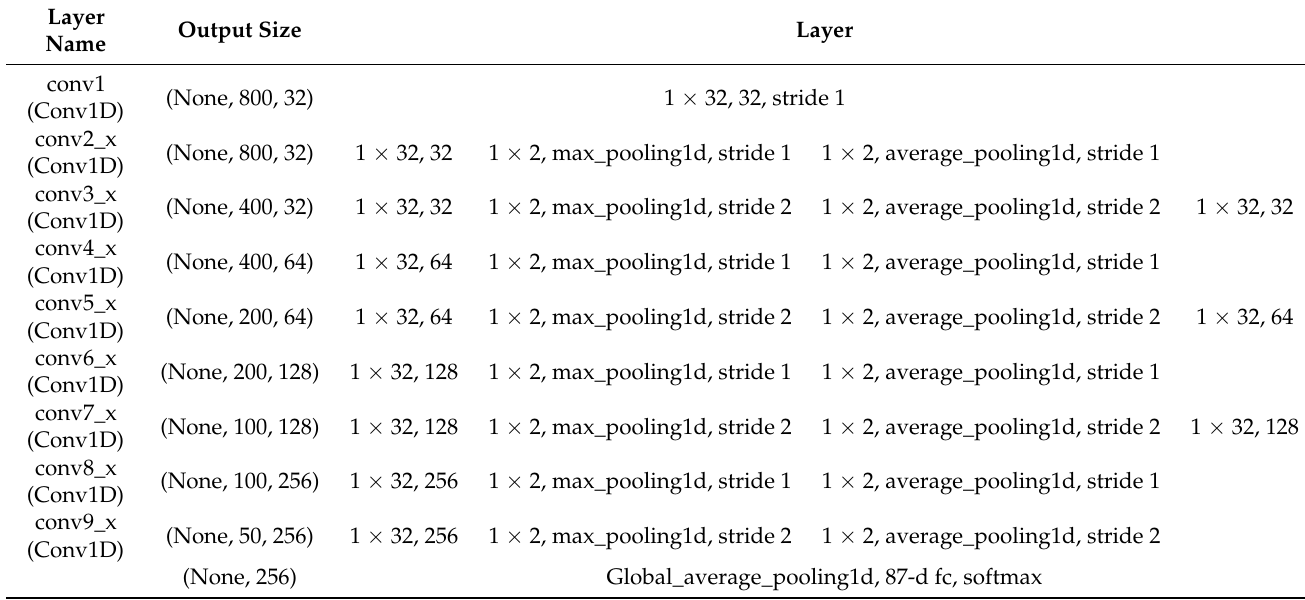
Table 1. Network model structure.